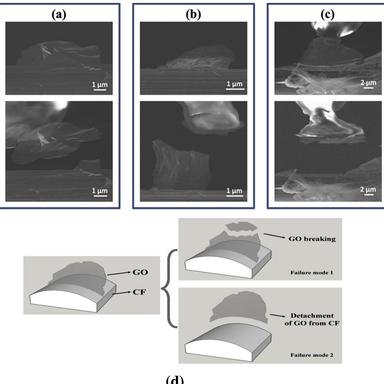
(a-c) SEM images of the pulling out procedure for three samples before loading and after fracture and (d) Schematic of two possible dominating failure mechanisms for pull-out testing.